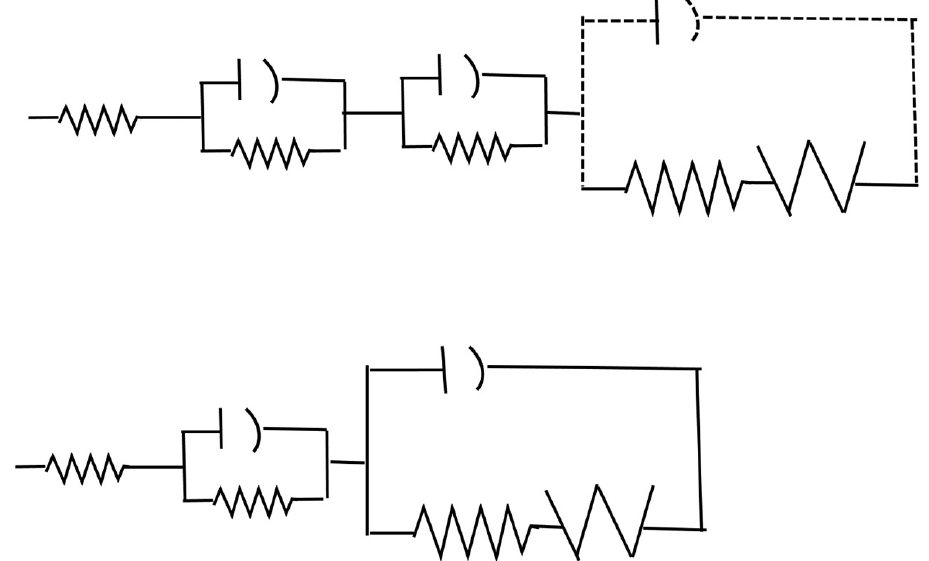
Figure A6. ( top ) Equivalent circuit of no-Zn test of Alloy 600 at − 623 mV. ( bottom ) Equivalent circuit of Zn test of Alloy 600 at − 623 mV.